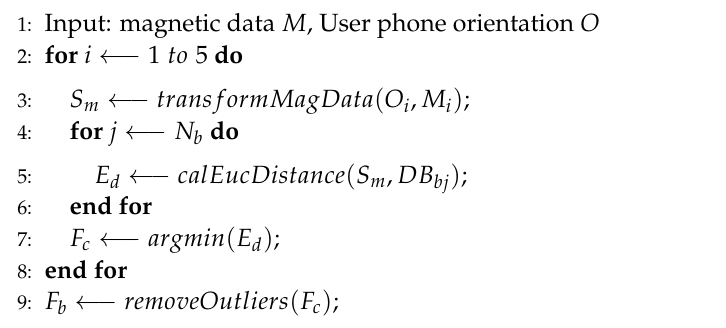
Algorithm 1 Floor Identification Using Magnetic Data